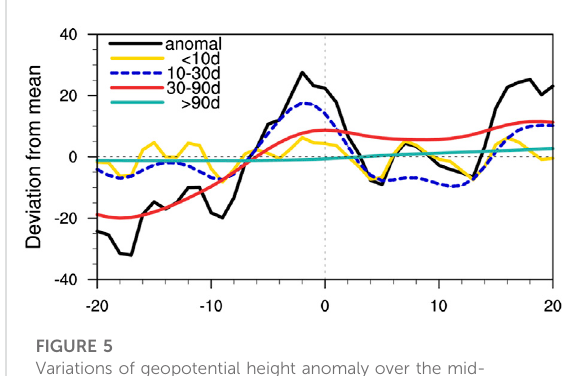
FIGURE 5 Variations of geopotential height anomaly over the mid- high-latitude key region at different time scales during Jiangnan Meiyu onset (unit: gpm; black, geopotential height anomaly; yellow, synoptic scale; blue, quasi-biweekly scale; red, intraseasonal scale; green, > 90 d scale).